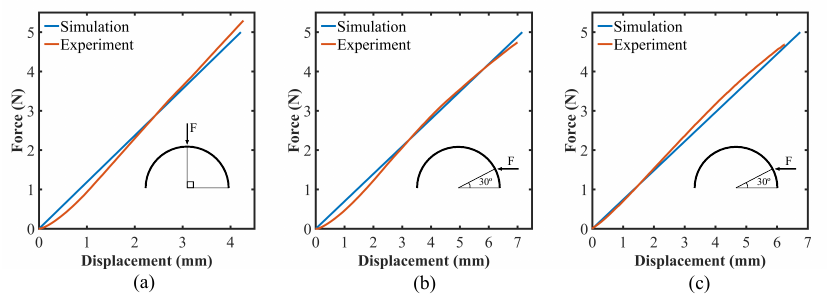
Figure 10. Sensor deformation for applied force ( a ) at 90 ◦ latitude; ( b ) at 30 ◦ latitude, between two sensors; ( c ) at 30 ◦ latitude, on one of the